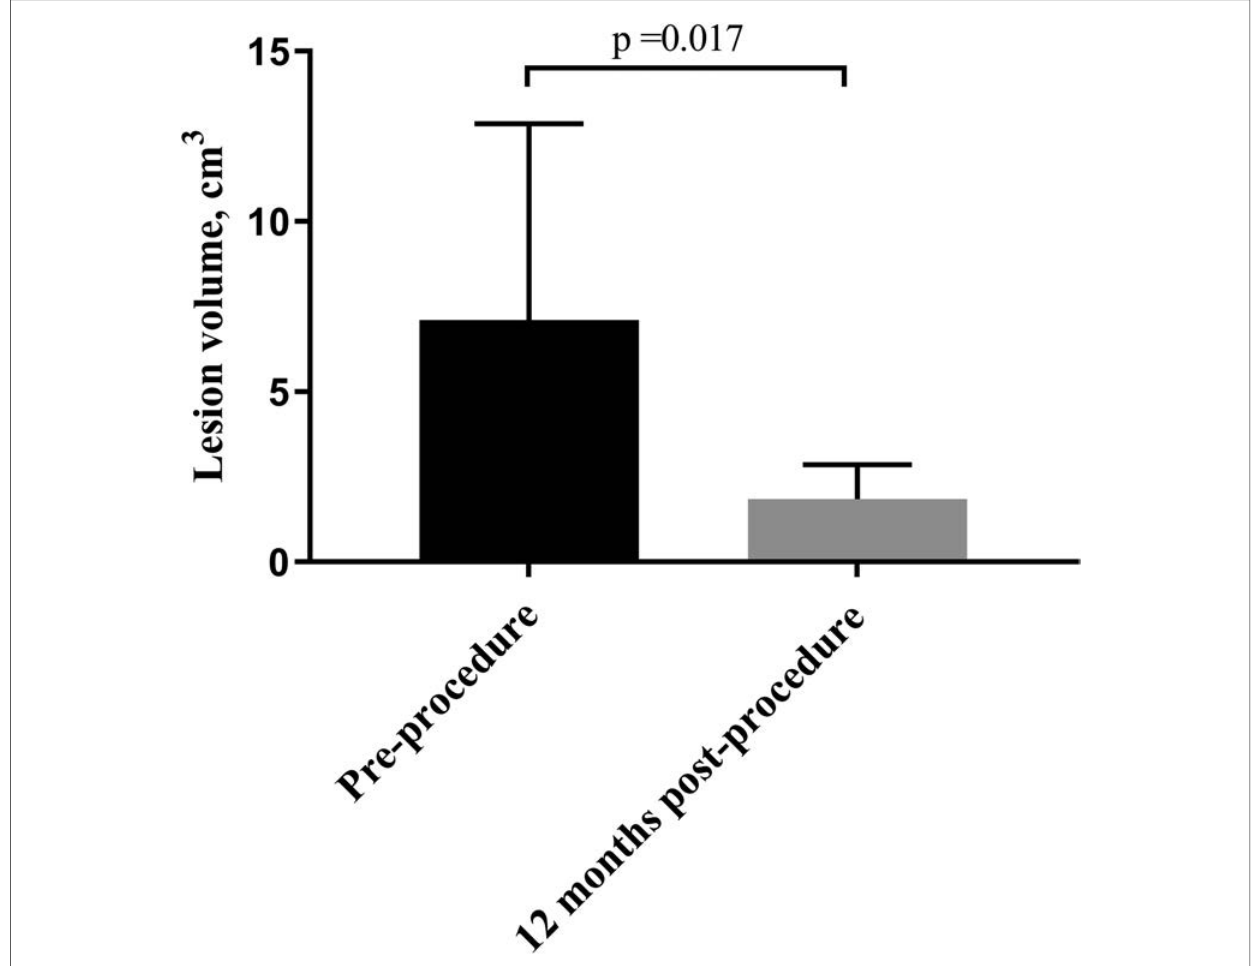
FIGURE 4 Comparison of pre- and post-procedure two-dimensional ultrasound evaluations of patients with AWE. Compared with the pre-procedure volume, the average volume of the AWE nodules was signi fi cantly decreased at the 12-month follow-up. AWE, Abdominal wall